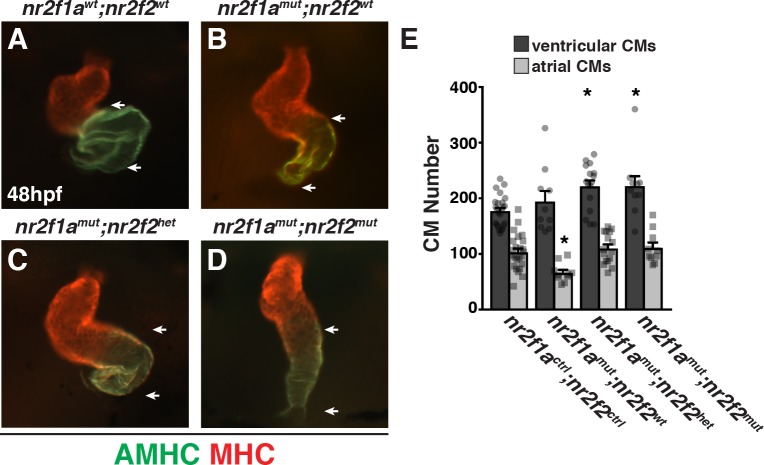
Nr2f1a functions redundantly with Nr2f2 to restrict ventricular CM number.(A-D) Frontal view of hearts from nr2f1awt; nr2f2wt, nr2f1amut; nr2f2wt, nr2f1amut; nr2f2het, and nr2f1amut; nr2f2mut embryos at 48 hpf with immunohistochemistry (IHC). Atria (AMHC)—green. Ventricles (MHC)—red. (E) CM number from hearts of nr2f1actrl; nr2f2ctrl (n = 24), nr2f1amut; nr2f2wt (n = 10), and nr2f1amut; nr2f2het (n = 16), and nr2f1amut; nr2f2mut (n = 10) embryos with the myl7:h2afva-mCherry transgene at 48 hpf. Although embryos WT for nr2f1a and nr2f2 alleles are shown in all images for comparison to nr2f1a; nr2f2 mutants, other allele combinations were indistinguishable from WT and pooled for data analysis. Therefore, nr2f1actrl; nr2f2ctrl indicates analysis performed with the combination of nr2f1awt; nr2f2wt; nr2f1ahet; nr2f2wt, nr2f1awt; nr2f2het, and nr2f1ahet; nr2f2het embryos.